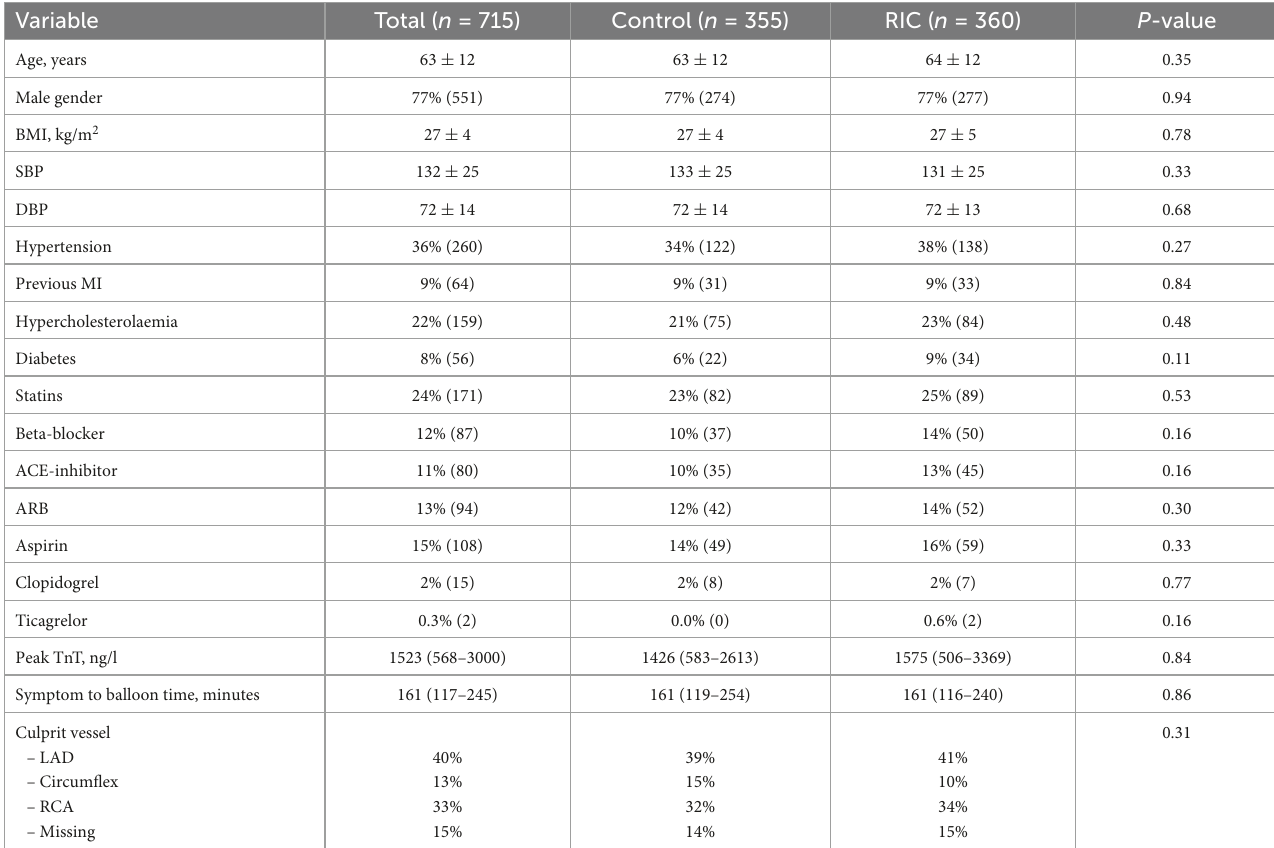
TABLE 1 Demographics at follow-up following myocardial infarction.